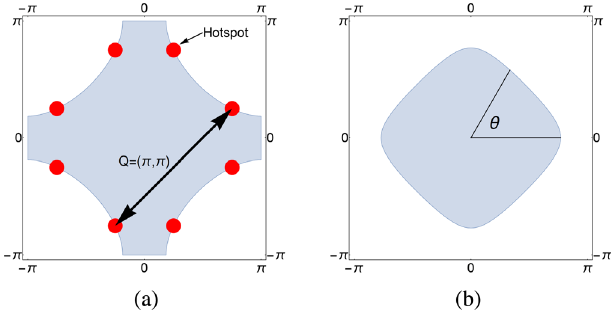
FIG. 1. FS structure of the spin-fermion and Ising-nematic metals. (a) FS structure of the spin-fermion model, which has four hole pockets, with “ hotspots ” connected by the AF ð π ; π Þ vector. (b) The electron FS in the nematic problem, with the FS angle θ denoted in the